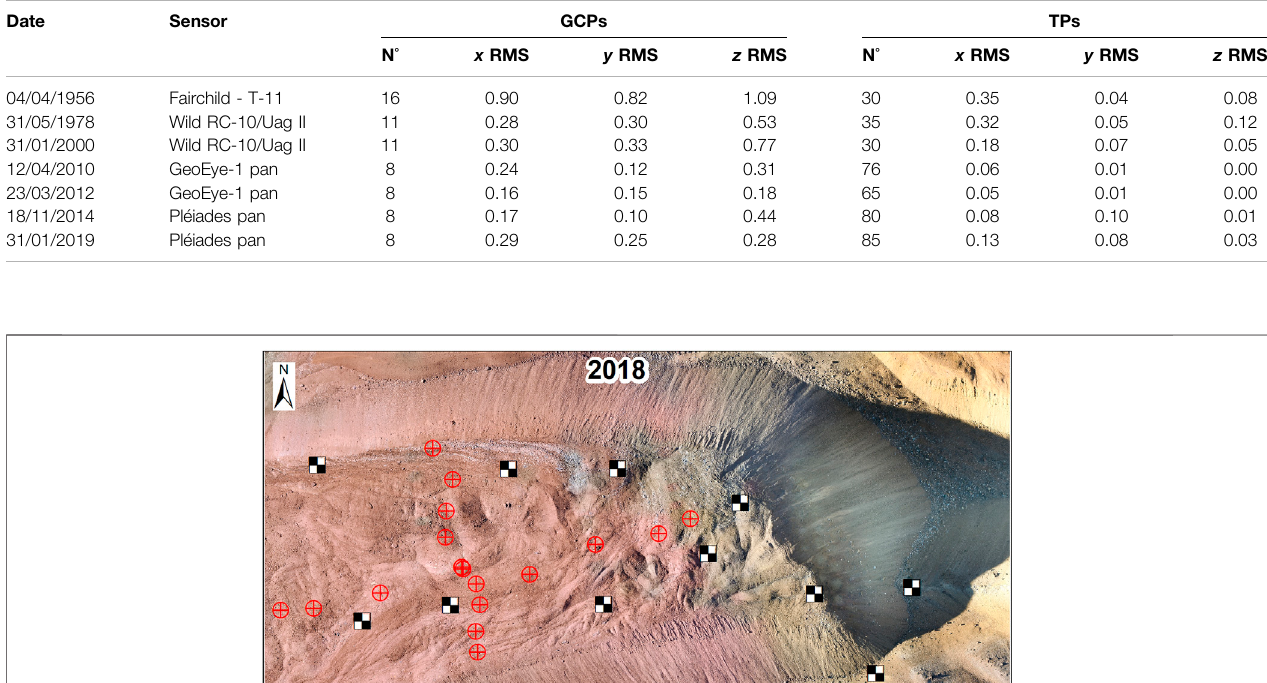
Frontiers in Remote Sensing |